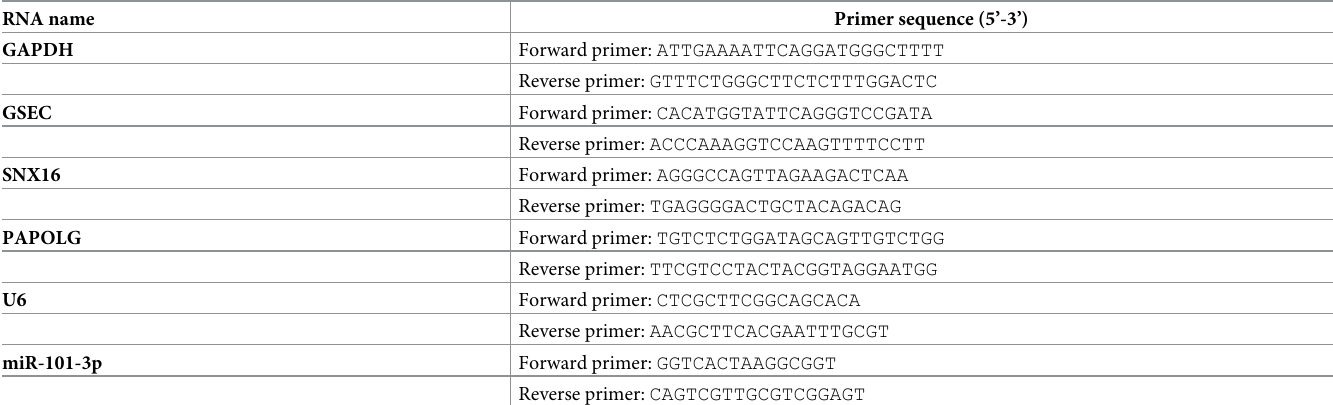
Table 1. Primer sequences for qRT-PCR. RNA